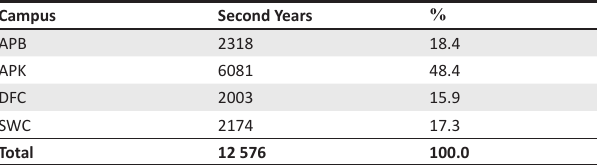
TABLE 1: The number of second year students registered at the University of Johannesburg in 2012.